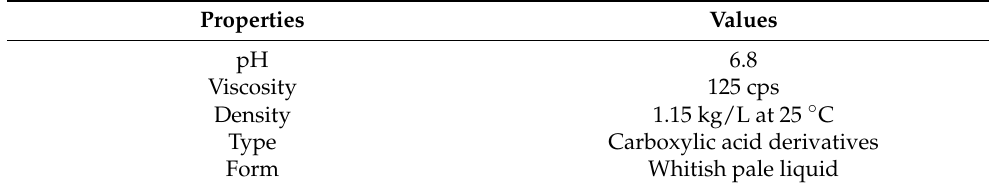
Table 1. Chemical properties of used cement, marble powder and silica fumes. Table 2. Properties of high-range water reducer.